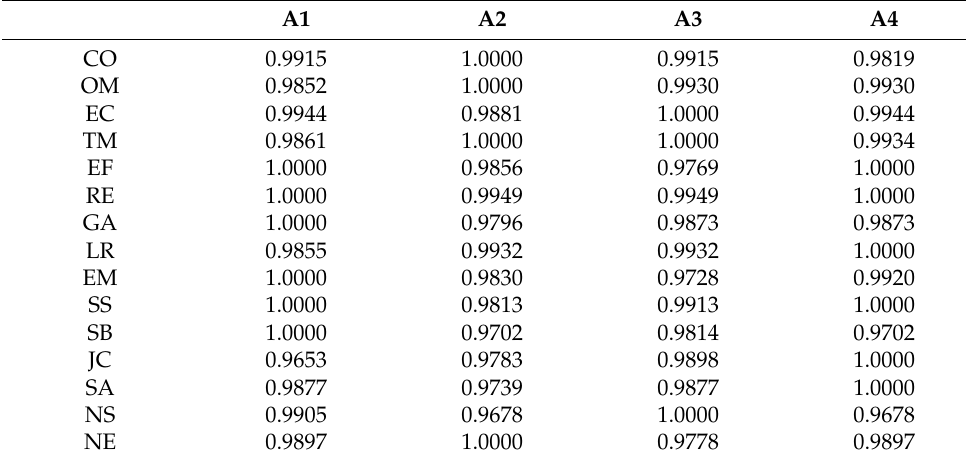
Table 7. Exponentially weighted Matrix.